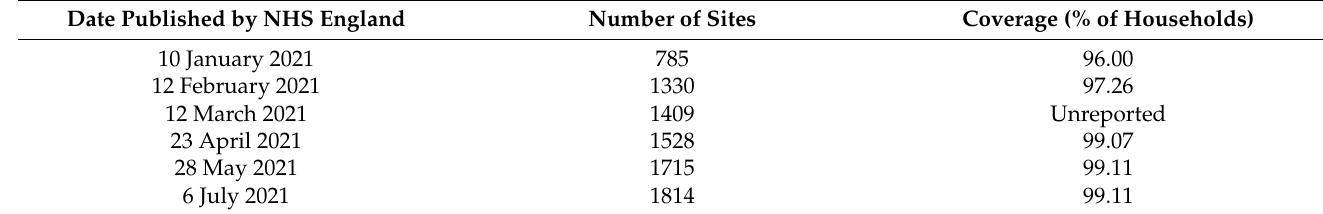
Table 1. Number of vaccination site locations (excluding hospital hubs) and NHS-reported coverage (percentage of the adult population within ten miles (16.1 km) of a vaccination site). Drawn from selected iterations of the NHS England published COVID-19 vaccination site lists between January and July